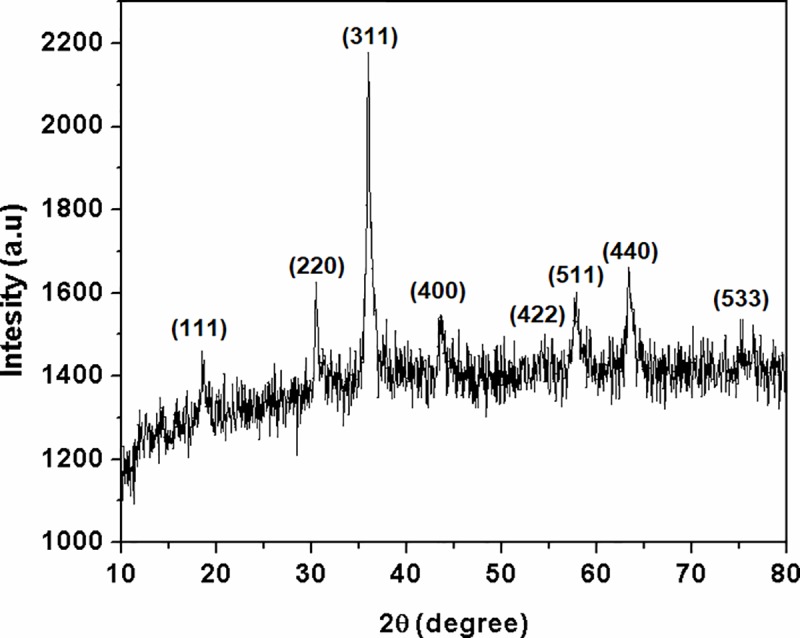
XRD pattern of 0.5MnO-0.5Co2O4 oxide system synthesized by citrate-gel combustion technique.The diagram indicates poorly crystallized (semiamorphous) MnCo2O4.